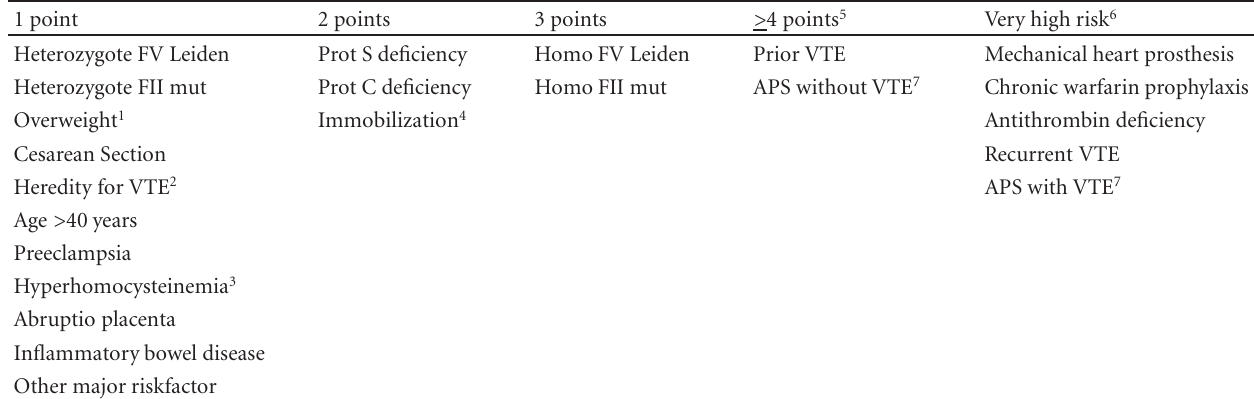
Table 2: Risk points, each corresponding to a five-fold increased risk, are added, yielding a risk score.